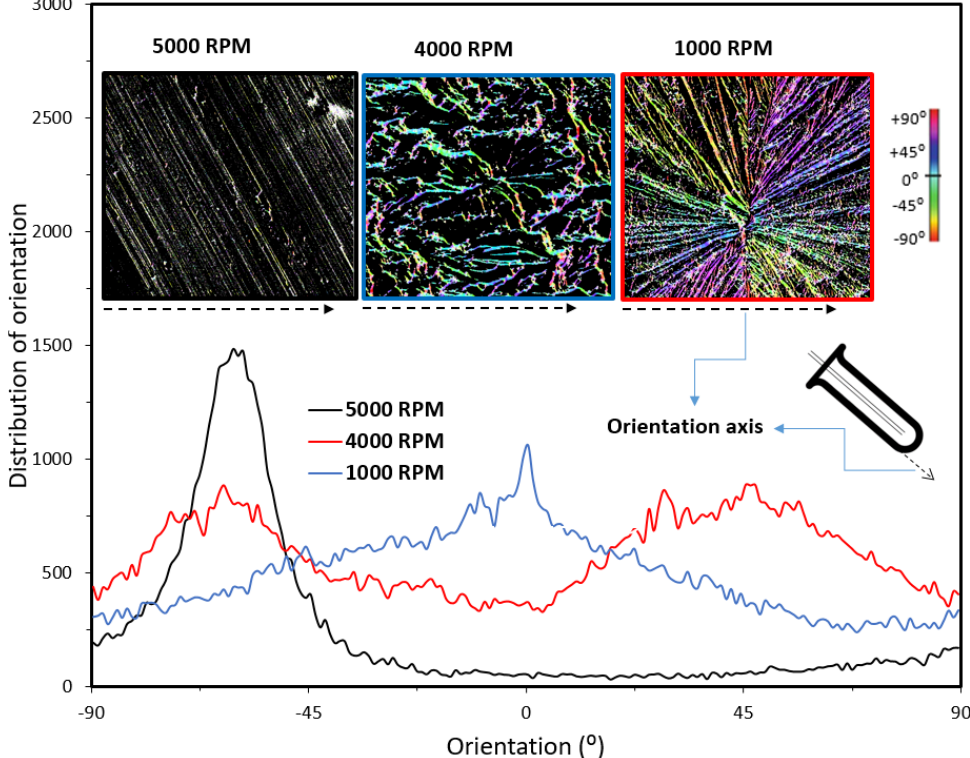
Figure 3. Distribution of the orientation of surface patterns in VFD-driven PVA hydrogels with different preferential directionalities. Insets: a VFD tube and color-survey images indicating the orientations of fibers relative to the orientation axis, denoted by black dotted arrows.